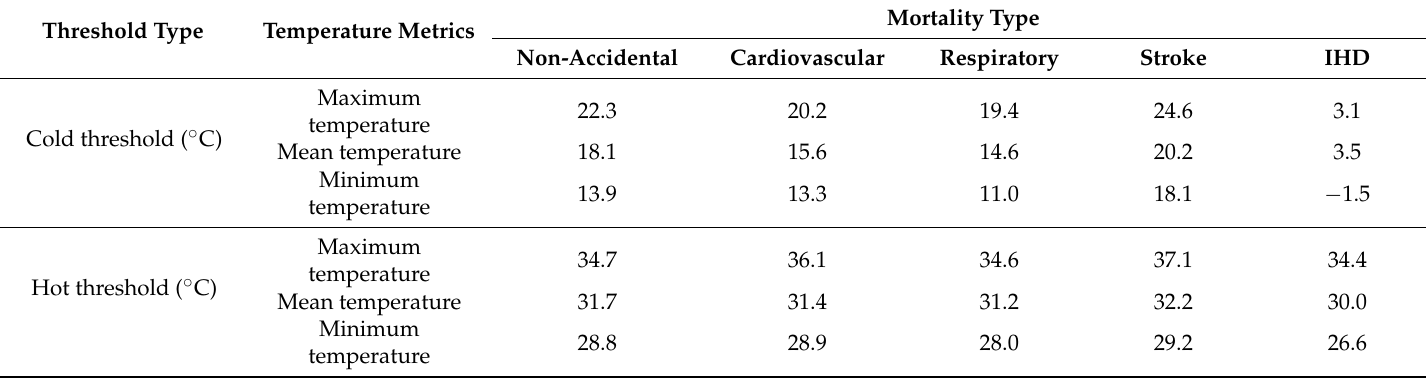
Table 4. Cold and hot thresholds ( ˝ C) used by the double-threshold-natural cubic spline